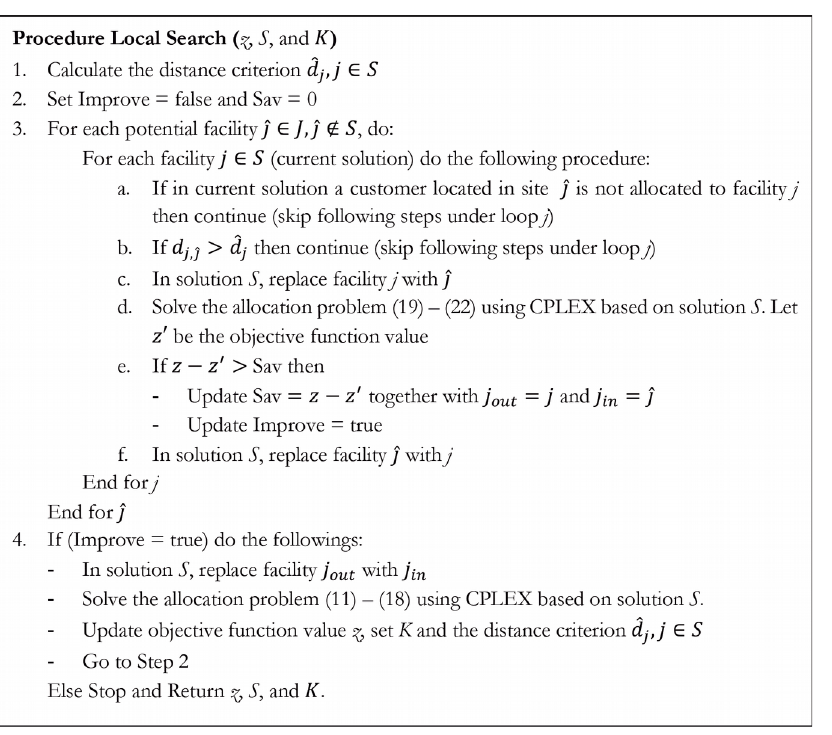
Figure 3. The local search main